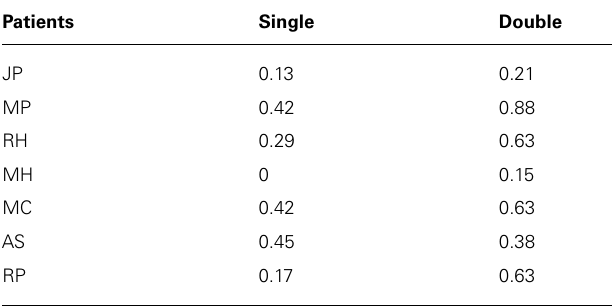
FIGURE 1 | Schematic view of the task. In all of the conditions patients were asked to verbally report whether a target letter x or z appeared in the centrally presented target array. In the low-load condition the target letter appeared alone in the central target array. In the high-load condition the target was intermixed with three non-target letters and in the dilution